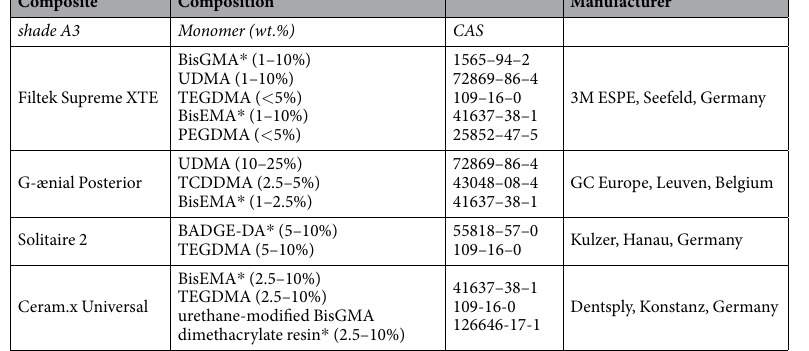
Table 3. List of the composites investigated and their composition as provided by the manufacturer’s safety data sheets. * BPA-based monomer. Abbreviations: BADGE-DA: bisphenol A diglycidyl ether diacrylate; BisEMA: ethoxylated bisphenol A glycol dimethacrylate; BisGMA: bisphenol A diglycidyl dimethacrylate; PEGDMA: polyethylene glycol dimethacrylate; TCDDMA: tricyclodecanedimethanol dimethacrylate; TEGDMA: triethylene glycol dimethacrylate; UDMA: urethane dimethacrylate.